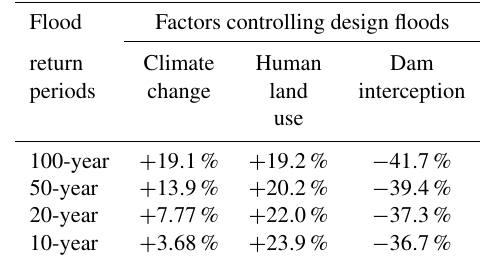
Table 2. Increase in the magnitude of design floods induced by cli- mate change in the Yalu River were estimated by comparing results during 1841–2012 and the LIA (1451–1840) for changes driven only by the climate change scenario (Case 1); the increase in design floods induced by human land use and the decrease caused by dams were estimated based on the results of three scenarios (Cases 1–3) during